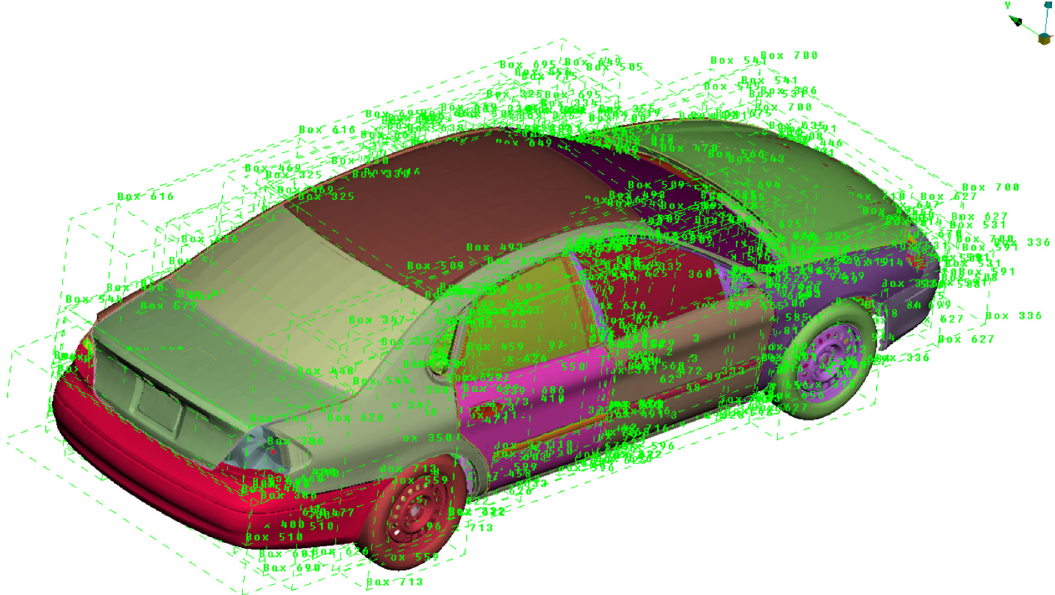
Fig. 6. R-Tree implementation for full car